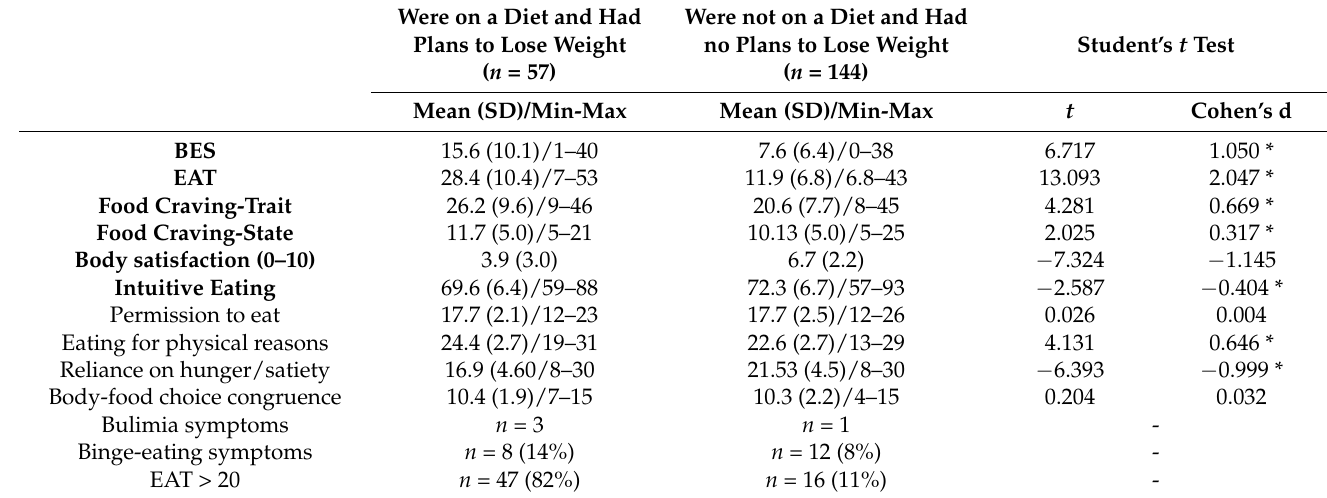
Table 1. Comparisons of eating behavior parameters as a function of diet